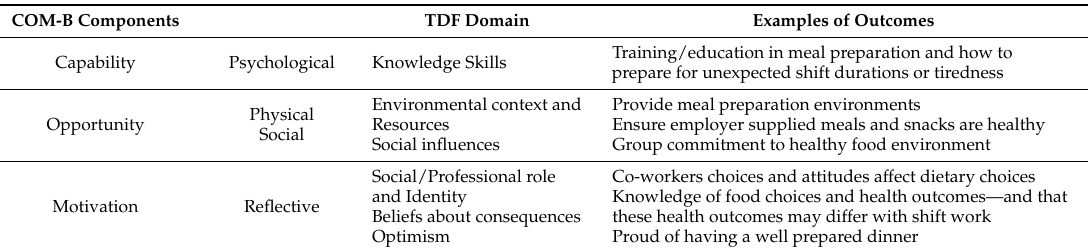
Table 5. Theoretical behaviour change components (COM-B) to address when implementing dietary changes for rotating shift